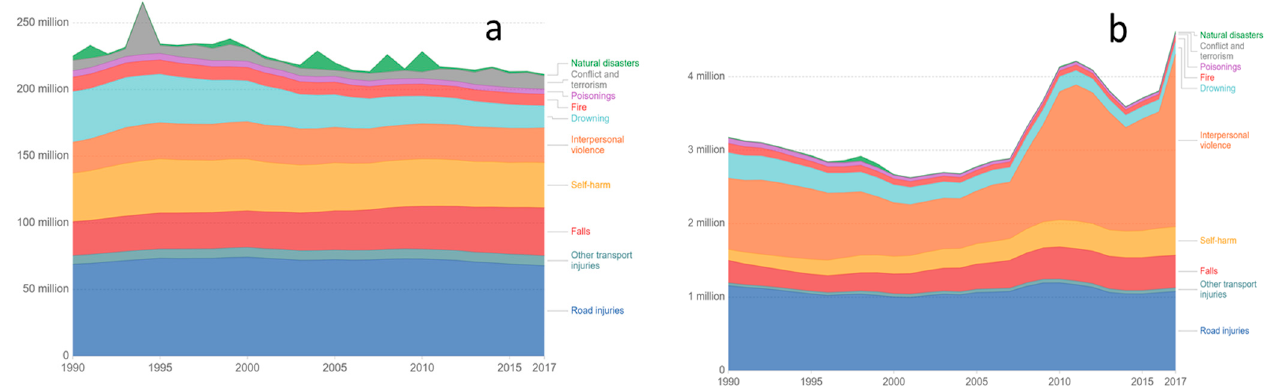
Figure A3. Burden of disease on the classification of injuries from 1990 to 2017. ( a ) Data for the worldwide population. ( b ) Data for the Mexican population. Disease burden is measured in disability-adjusted life years (DALYs). DALYs are used to measure total of disease—both from years of life lost and years lived with a disability. One DALY equals one lost year of healthy life. Information provided by Institute for Health Metrics and Evaluation [45].